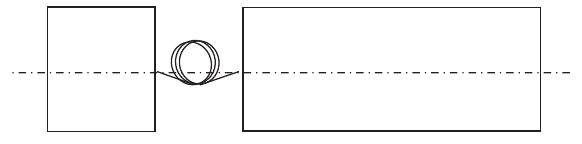
Figure 2: The model of the crack torsion line